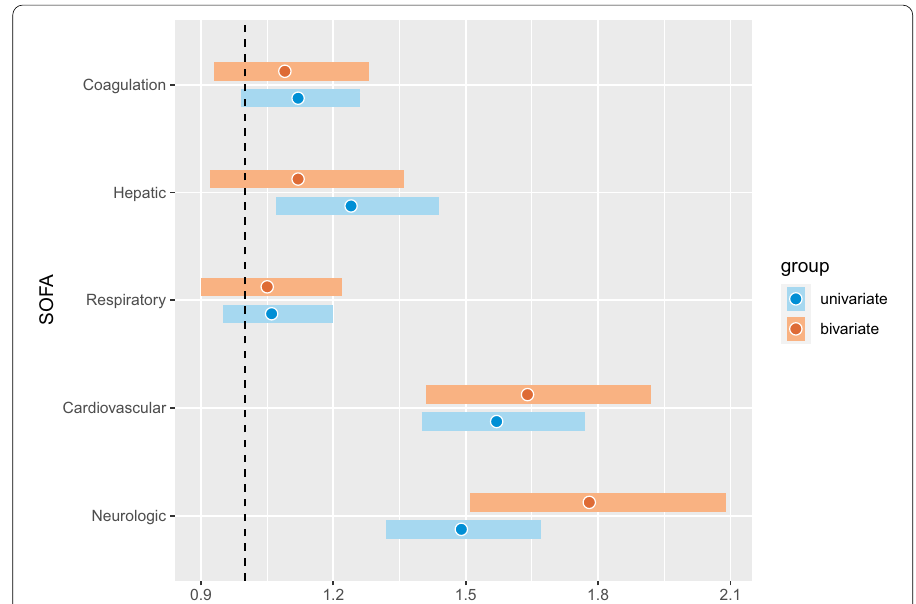
Fig. 3 Odds ratios for penKid (proenkephalin A 119–159) in ordinal logistic regression of organ specific SOFA scores in a univariate and a bivariate (including admission creatinine)